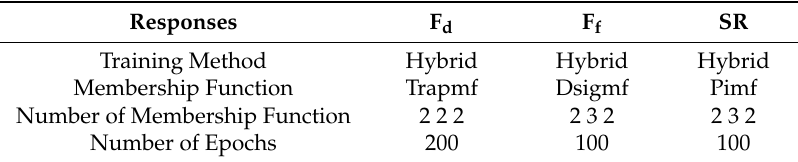
Table 8. Selected parameters for designing ANFIS